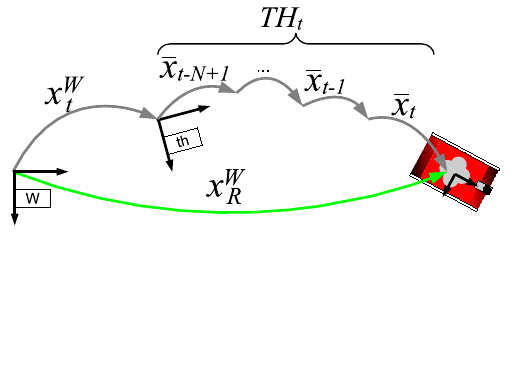
denotes the robot R